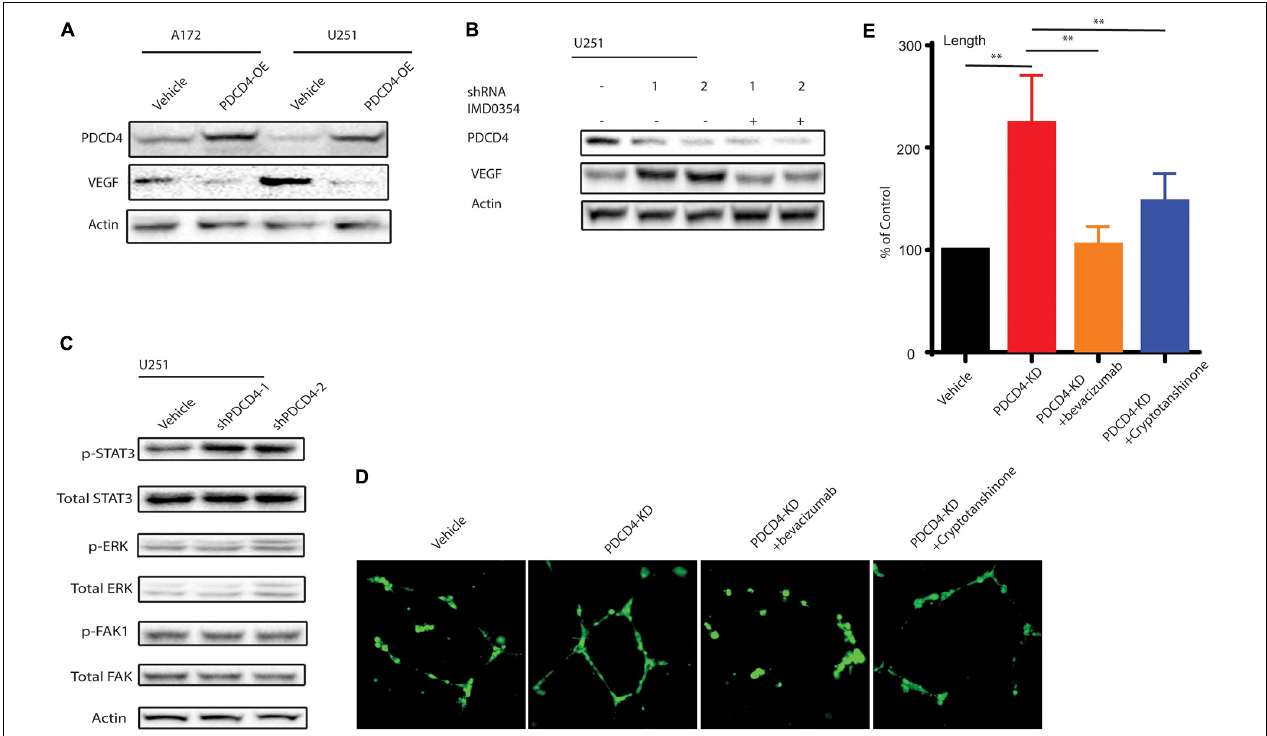
FIGURE 4 | PDCD4 regulates angiogenesis via VEGF-STAT3 pathway. (A) Western blot analysis showing VEGF levels in cells over-expressing PDCD4 . (B) Western blot analysis indicating VEGF expression PDCD4 -depleted cells treated under indicated conditions. (C) Western blot analysis depicting p-STAT3 levels in PDCD4 -knockdown cells. (D) Representative annotated images showing areas of tubes, loops, and branching points in HUVEC cells cultured with the indicated cells. (E) Quantification of length of tubes formed in response to indicated treatment. ** P < 0.01.